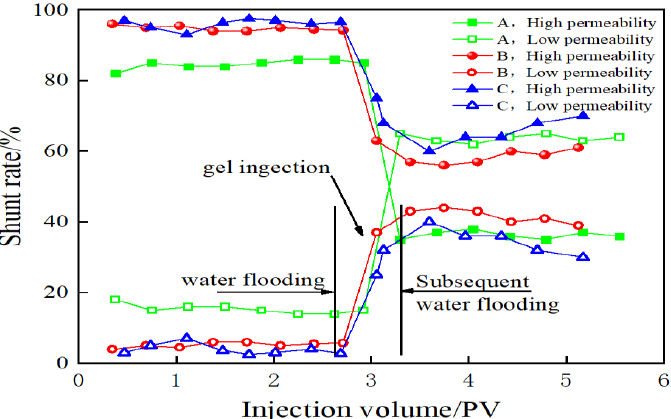
Figure 14. Variation in the flow rate of high- and low-permeability layers in cores with different permeability levels as a function of injection volume (A: Permeability ratio: 5; B: Permeability ratio: 40; C: Permeability ratio: 200).